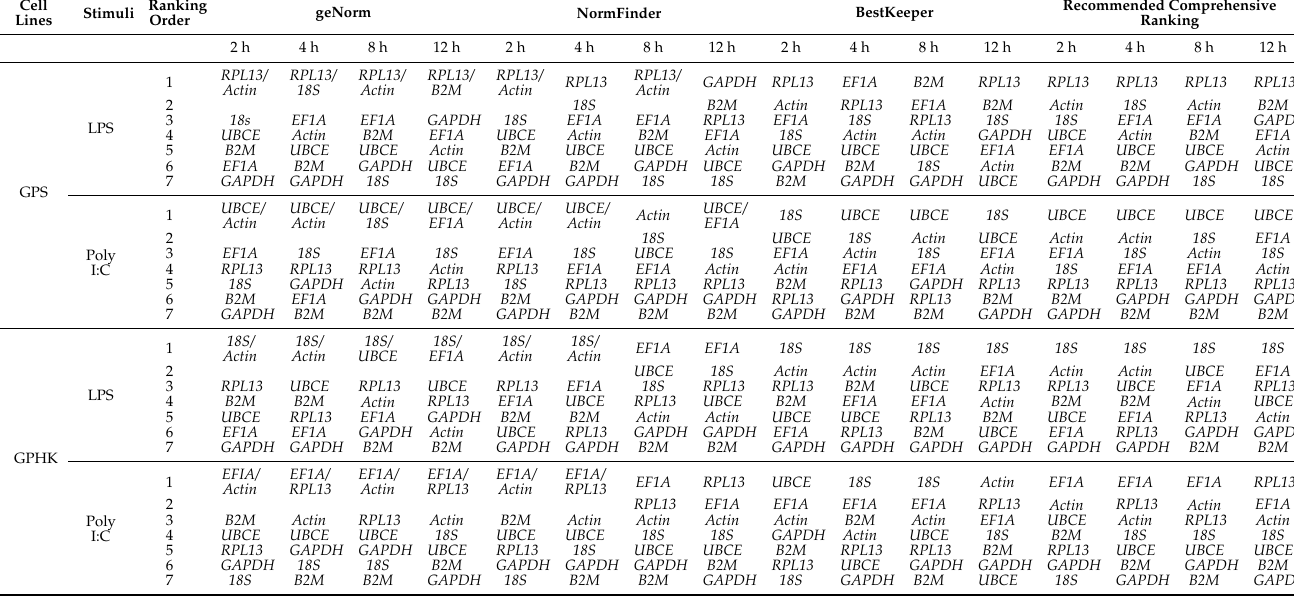
Table 9. The recommended comprehensive ranking of housekeeping genes based on three algorithm analyses in GPS and GPHK cells under stimulation with LPS and Poly I:C for 2, 4, 8 and 12